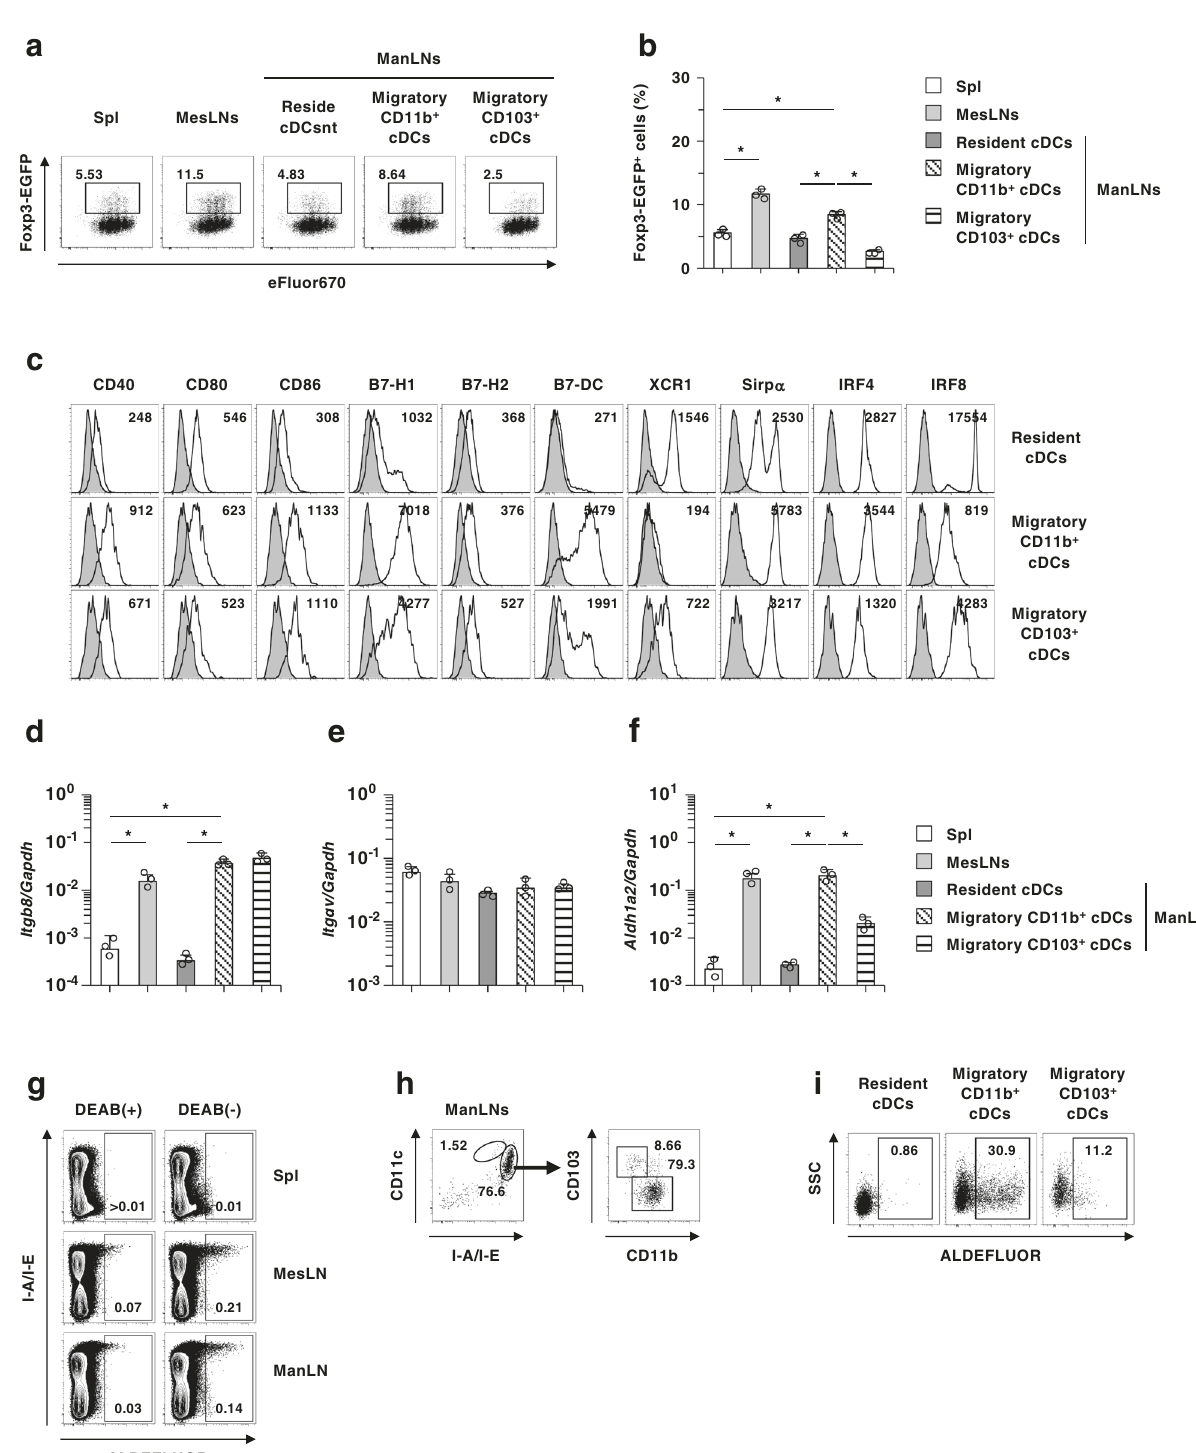
Fig. 5 ManLNs migratory CD11b + cDCs induces antigen-speci fi c CD4 + Foxp3 + pT reg cells in vitro. a , b eFluor ™ 670-labeled KJ1 – 26 + CD4 + Foxp3 EGFP − T cells were cultured with cDCs isolated from spleen, MesLNs, and ManLNs under pT reg -polarized culture conditions for 5 days. Cell surface expression pro fi le a and proportion b of KJ1 – 26 + CD4 + Foxp3 EGFP − T cells. c Cell surface expression pro fi le of ManLNs cDCs subset under steady-state condition, and numbers represent mean fl uorescence intensity (MFI). d – f Transcriptional expressions of Itgb8 d , Itgav e , and aldh1a2 f in cDCs isolated from spleen, MesLNs, and ManLNs. g – h Leukocyes in spleen, MesLNs, and ManLNs obtained from WT mice were incubated with ALDEFLUOR in the presence or absence of diethylaminobenzaldehyde (DEAB) for detection of ALDH activity. g Cell surface expression pro fi le of ALDEFLUOR + cells in spleen, MesLNs, and ManLNs. h , i Cell surface expression pro fi le of I-A/I-E hi ALDEFLUOR + cells h and ALDEFLUOR + cells in each cDCs subset in ManLNs i . Data are obtained from fi ve individual samples in a single experiment. * P < 0.05 compared with among groups. All data are representative of at least three independent